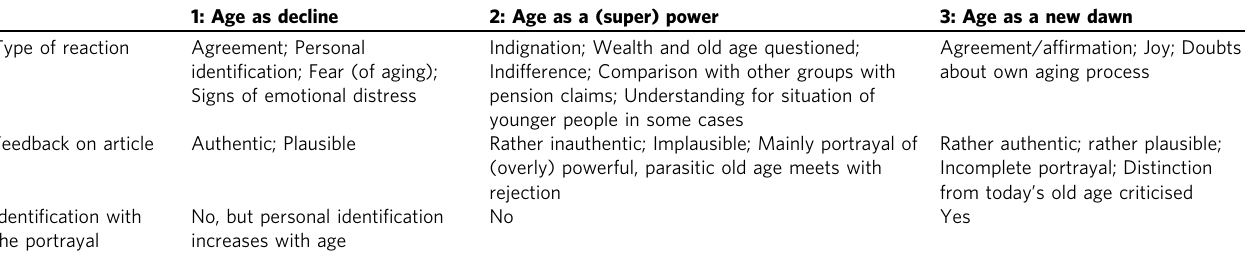
Table 2 Reception of age frame compared, focused